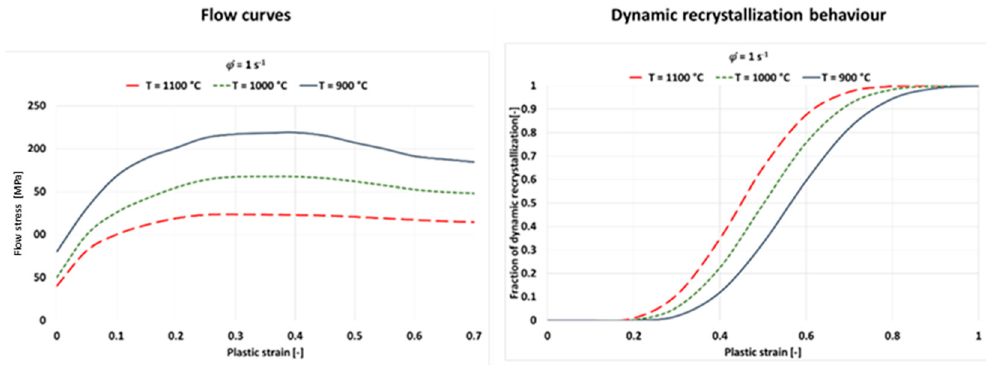
Figure 17. Flow curves and dynamic recrystallization for a strain rate of 1.0 s –1 of weld metal.